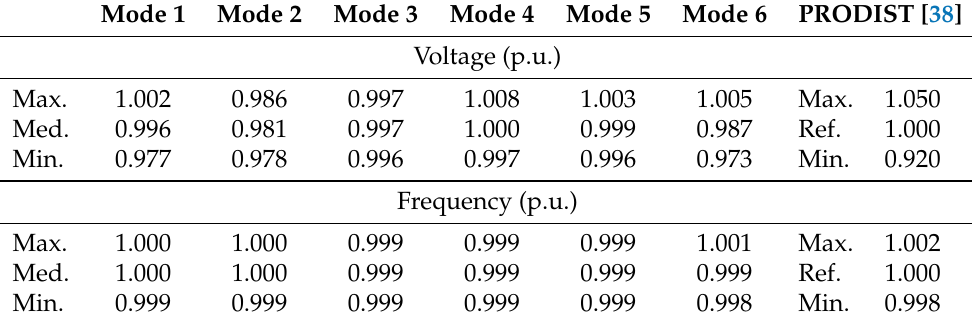
Figure 5. System voltage and frequency collected by power analyzer. Table 3. Quality of energy off-grid in comparison with